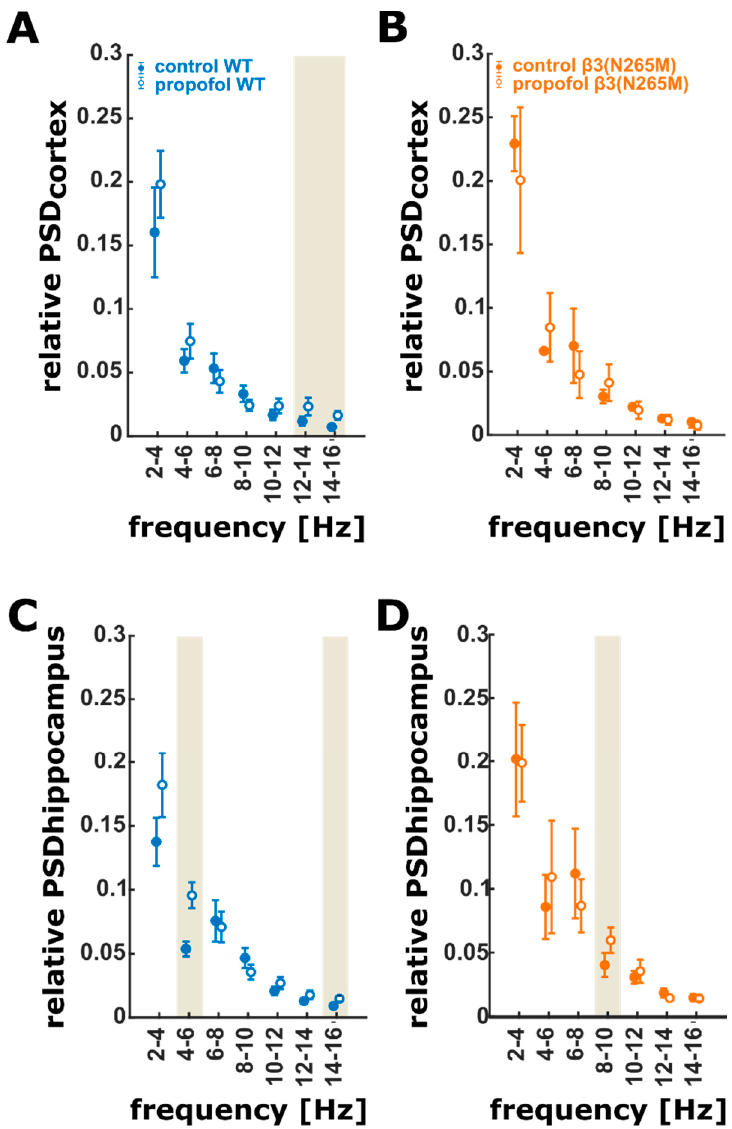
Figure 1. PSD error bar plots of the 2 Hz frequency ranges (mean ± sem). ( A ) LFP recorded from the cortex in the wild-type mice. Propofol has a significant and medium effect on the 12–14 Hz and a significant and strong effect on the 14–16 Hz (Hedges’ g: 1.01; CI: (0.38 to 1.96)) frequency range. In both frequency ranges, propofol causes an increase in relative power. ( B ) There is no significant effect of propofol on the PSD of LFP activity recorded from cortex in the β 3(N265M) group. ( C ) In the hippocampal LFP recordings from wild-types, propofol significantly and strongly increased relative power in 4–6 Hz range and in the 14–16 Hz range (Hedges’ g: 0.90; CI: (0.26 to 1.78)). ( D ) Propofol caused a significant and strong increase in relative power in the 8–10 Hz range of LFP recorded from the hippocampus of the β 3(N265M) mice. The ivory areas indicate significance, i.e., a 95% confidence interval of Hedge’s g exclusive 0; wild-type ( n = 4), β 3(N265M) knock-in mice ( n = 3); PSD: power spectral density. LFP: local field potential, CI: 95% confidence interval.